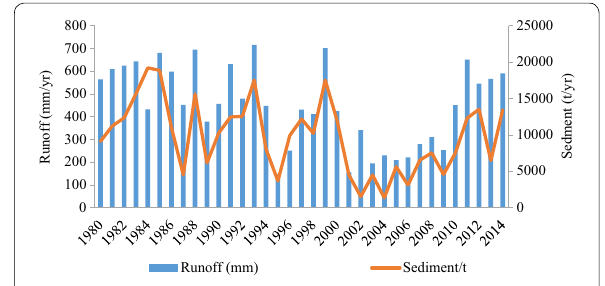
Fig. 9 Annual sediment yield and runoff